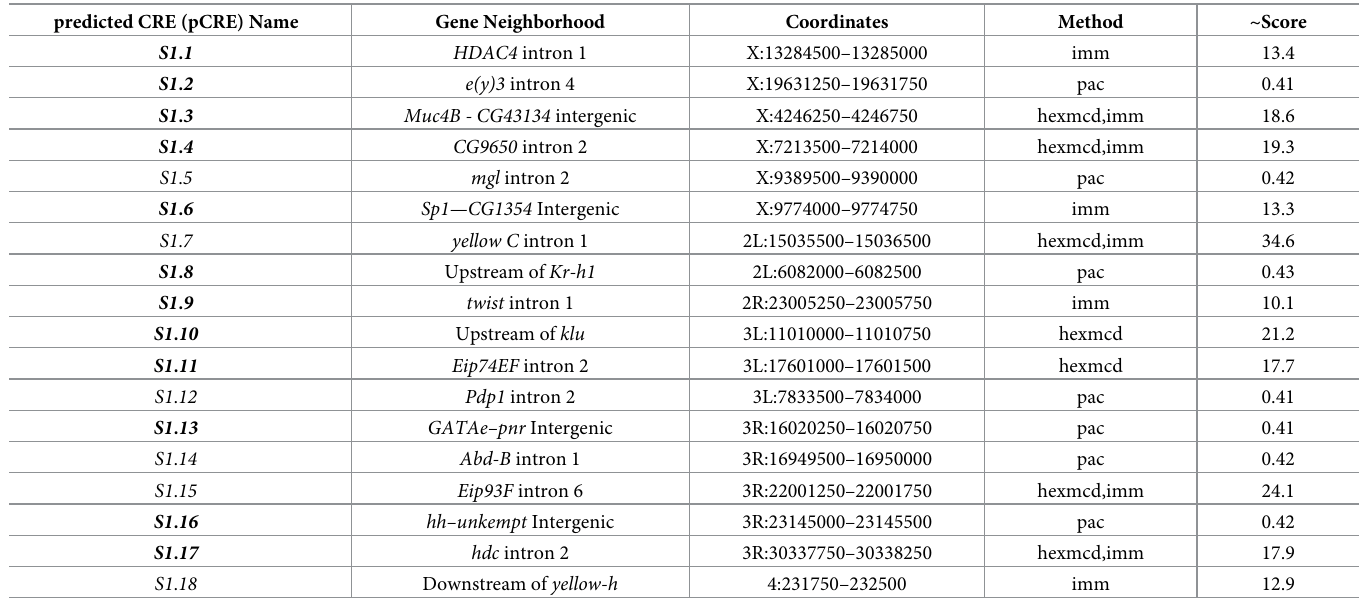
Table 1. Pertinent information for the 18 SCRMshaw predicted CREs that were evaluated in Drosophila melanogaster reporter transgene assays. predicted CRE (pCRE)